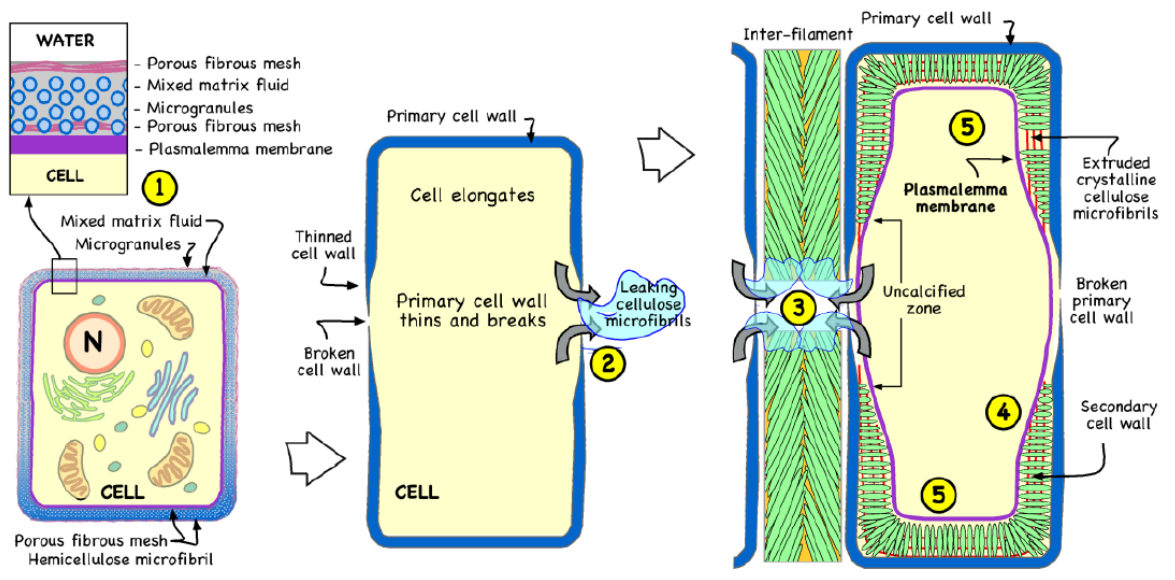
Figure 11. Skeletal formation in red algae. Process steps: (1) Primary cell wall is forming. Hemicellulose microfibrils act as nucleating substrate for micro-granules. (2) Cellulose microfibrils extrude from plasma membrane and leaks through broken primary cell wall. (3) Interfilament grains initiate attached to the external part of the primary cell wall and grow in the leaked cellulose microfibril. (4) Secondary cell wall thickens, extruded cellulose microfibrils stop leaking and mineralize as Mg-calcite. (5) Plasmalemma is pushed inward as cellulose microfibrils continue to extrude and mineralize. Secondary cell wall fully formed. (This figure is an original interpretation by L. Pomar based on sources including [80]).